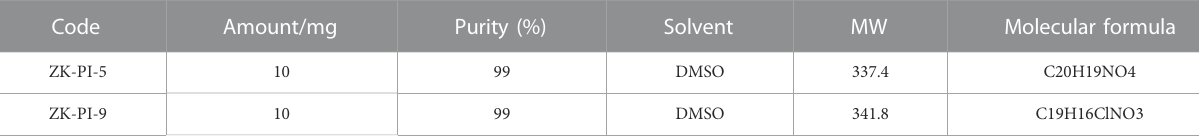
TABLE 1 Molecular formulas and relative molecular masses of ZK-PI-5 and ZK-PI-9.